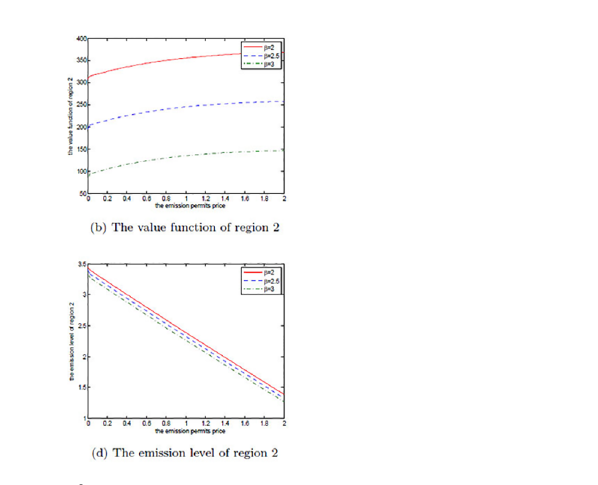
Fig 5. The effects of β on the noncooperative game.